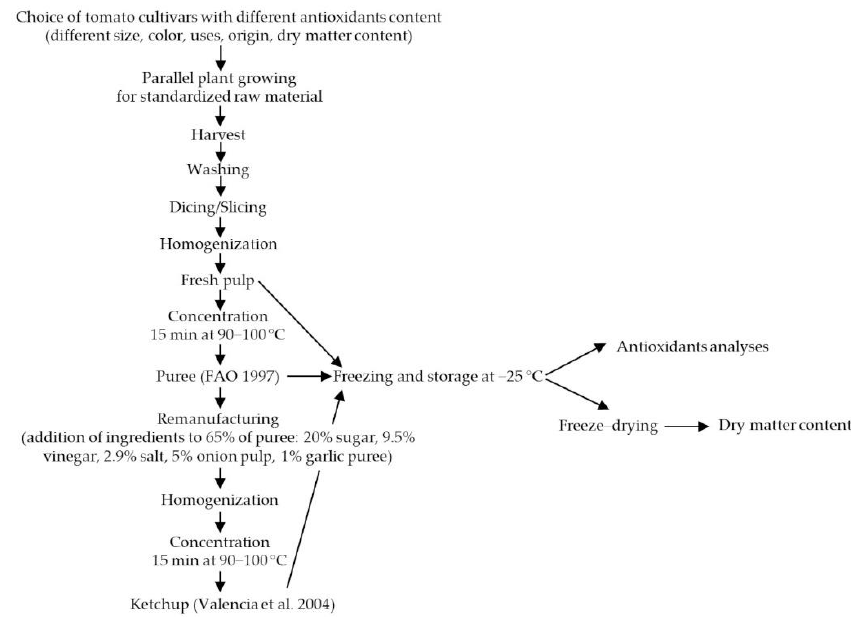
Figure 1. Flowchart of the experimental procedure from the choice of the tomato cultivar until final analyses.